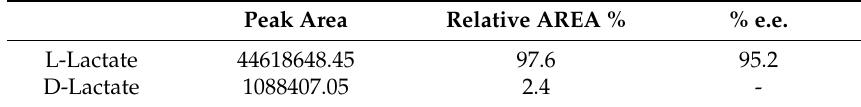
Table 2. Optical purity of L-lactic acid from T. neapolitana cultures under CLF conditions. Peak area of L- and D- derivatives were obtained by GC/MS. The experiment was carried out in duplicate. e.e.: enantiomeric excess. 146